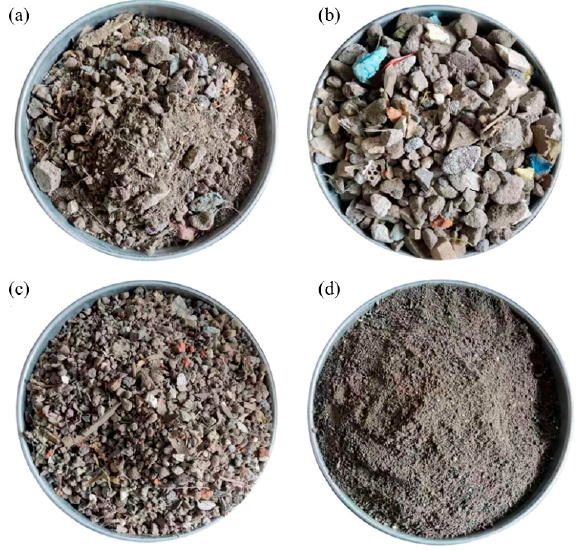
Figure 15. Samples of (a) raw material, (b) oversize, (c) middle, and (d) undersize products.